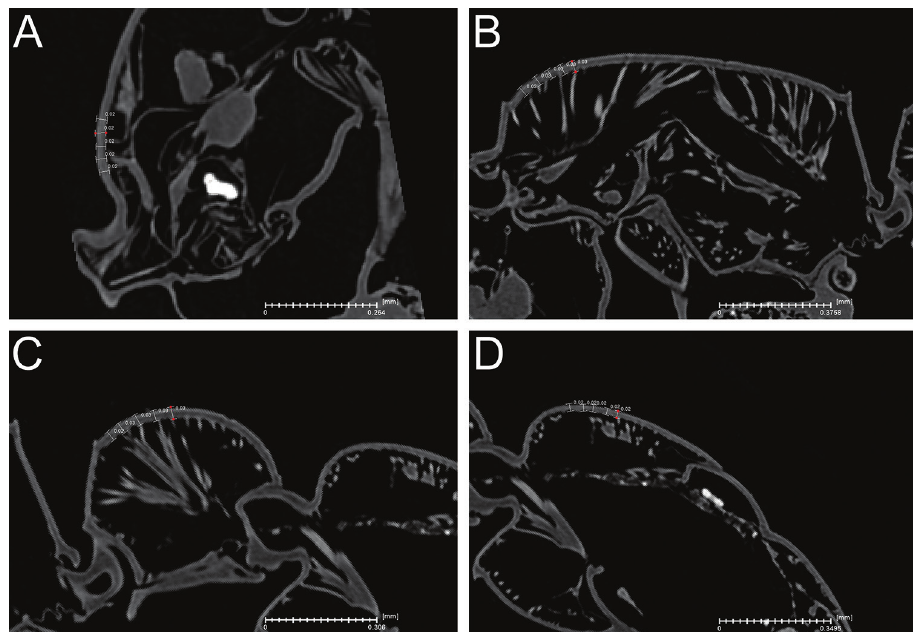
Figure 2. Microtomographic slides showing cuticle thickness measurements (with measuring lines in white). A Head in profile B Mesosoma in profile C Petiole (abdominal segment II) in profile D Abdomi- nal segment III in